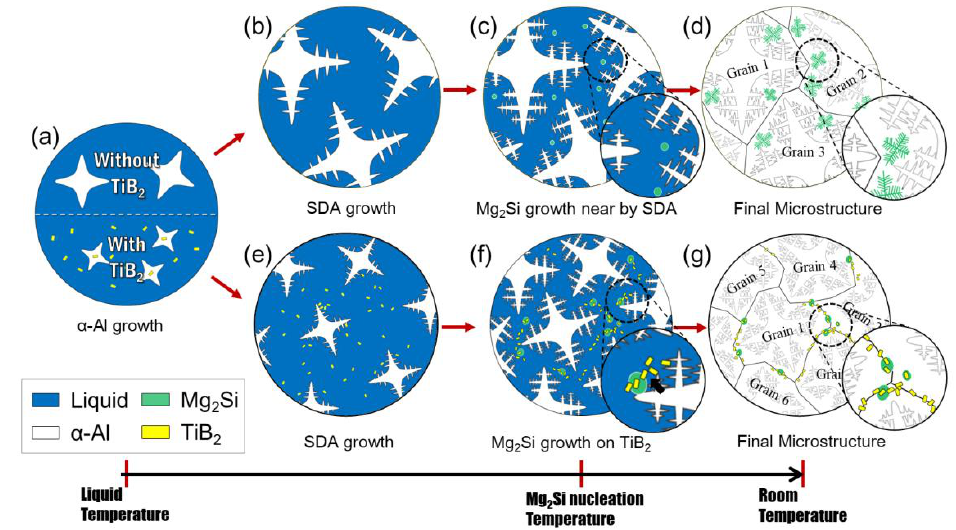
Figure 7. Schematic presentation of the solidification processes of eutectic Al + Mg 2 Si phases in aluminum alloys: ( a ) → ( b ) → ( c ) → ( d ) without TiB 2 particles; ( a ) → ( e ) → ( f ) → ( g ) with TiB 2 particles.